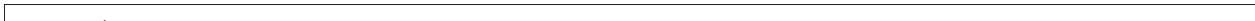
FIGURE 6 | (C) Doppler imaging: Blood flow in the femoral arteries of WTWT, WTKO, and KOKO mice at 4 wks after wire injury were monitored using a LDPI analyzer. Arrows indicate blood flow in the injured femoral artery. Photographs are representative of 4–5 independent experiments. H&E: Cross sections of the femoral arteries of WTWT, WTKO, and KOKO mice at 4 wks after wire injury were stained with H&E. CD36 & α -SMA: Infiltrating macrophages in indicated neointima was stained with anti-CD36 antibody, and VSMCs were stained with anti- α -SMA antibody. Photographs are representative of 4–5 independent experiments. Bottom: LDPI ratio was quantified as the ratio of the blue-to-red pixels in the injured artery (WI) vs. non-injured arteries (Control). Neointima volumes were determined using an image analyzer. Numbers of CD36-positive cells within neointima area in the injured artery of WT and BLTR1-deficient mice were quantified, and data were expressed as the means ± SEMs of 4–5 independent experiments. ** P < 0.01 vs. WTWT mice, ## P < 0.01 vs. KOKO